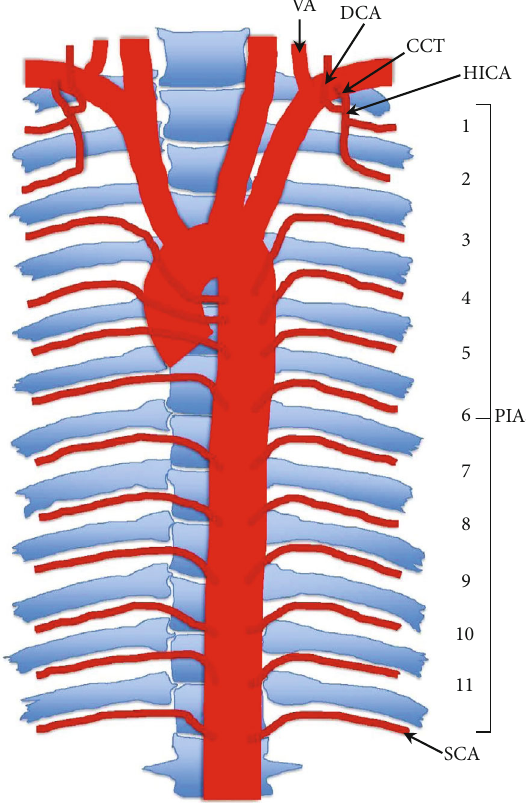
Figure 1: Graphic representation of typical arterial branching pattern of the posterior thoracic wall. VA: vertebral artery; DCA: deep cervical artery; CCT: costocervical trunk; HICA: highest intercostal artery; PIAs: posterior intercostal arteries; SCA: subcostal artery.